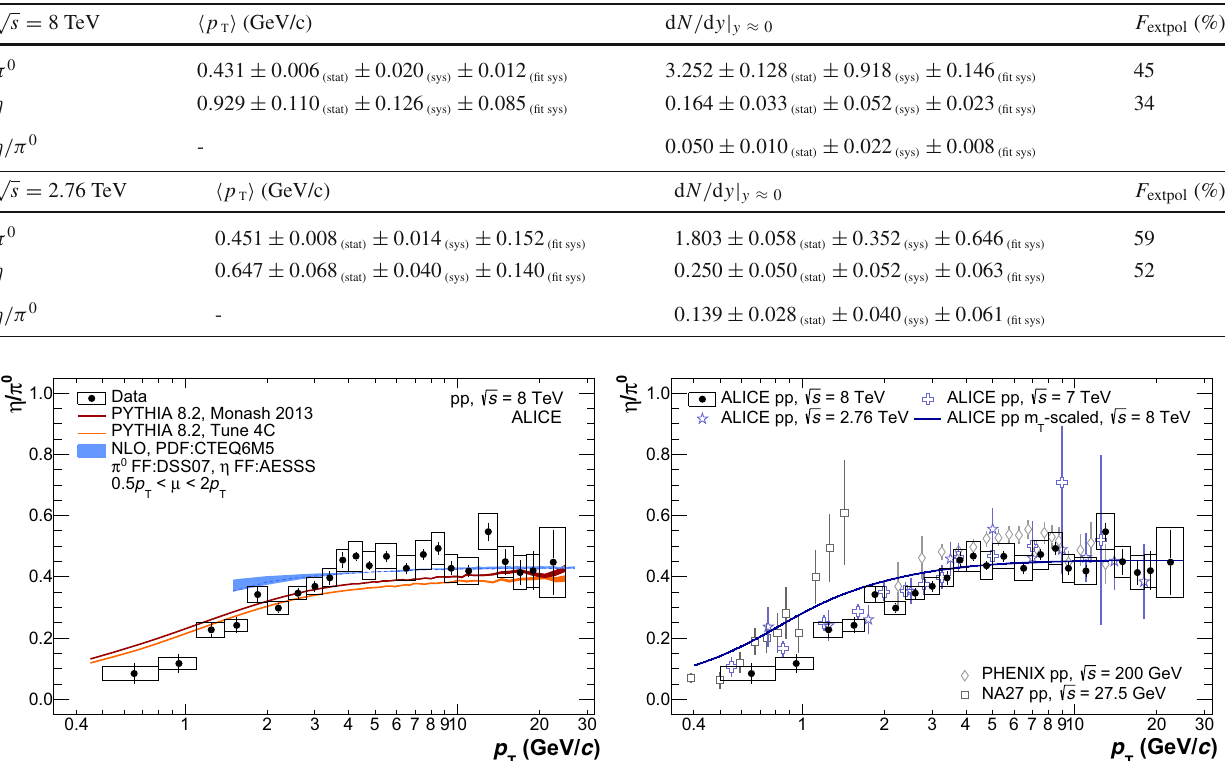
(cid:9) , and integrated yields, includedforthegivennumbers,whichare + 3 . 9% − √ √ T s = s = 2 . 76 TeV [29] and ± 2 . 3% for 8 TeV [59]. Moreover, the for integrated η/π 0 ratios are quoted for the different energies